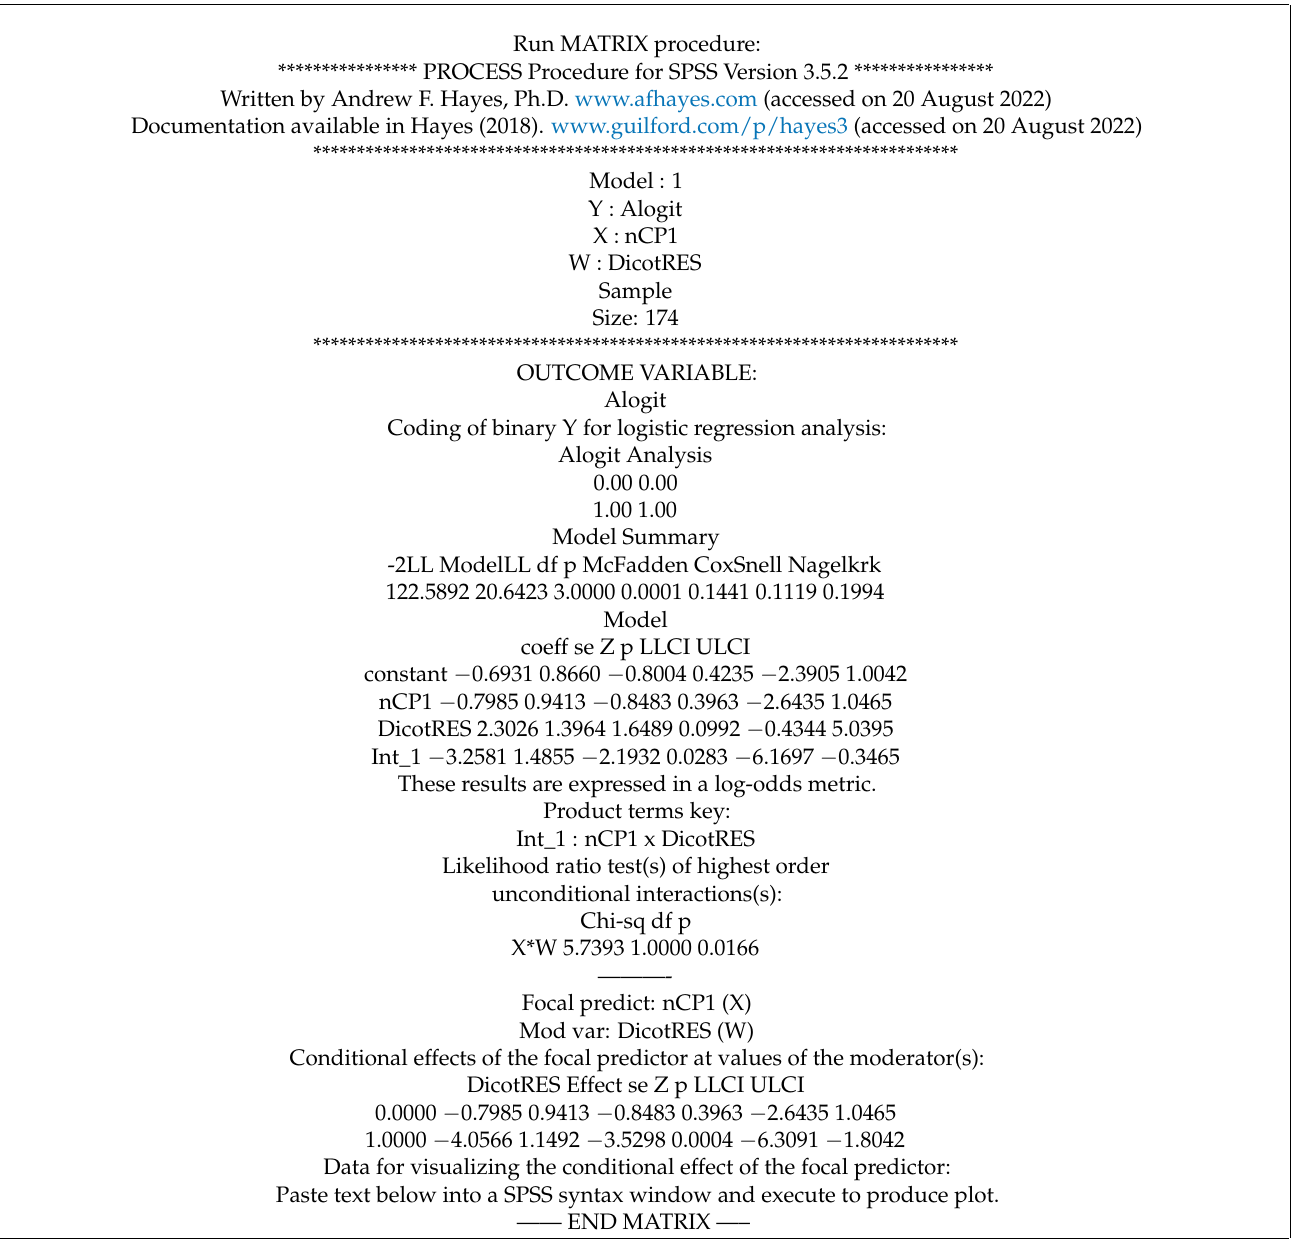
Table A4. Analysis result on the moderating effect of Resilience. Run MATRIX